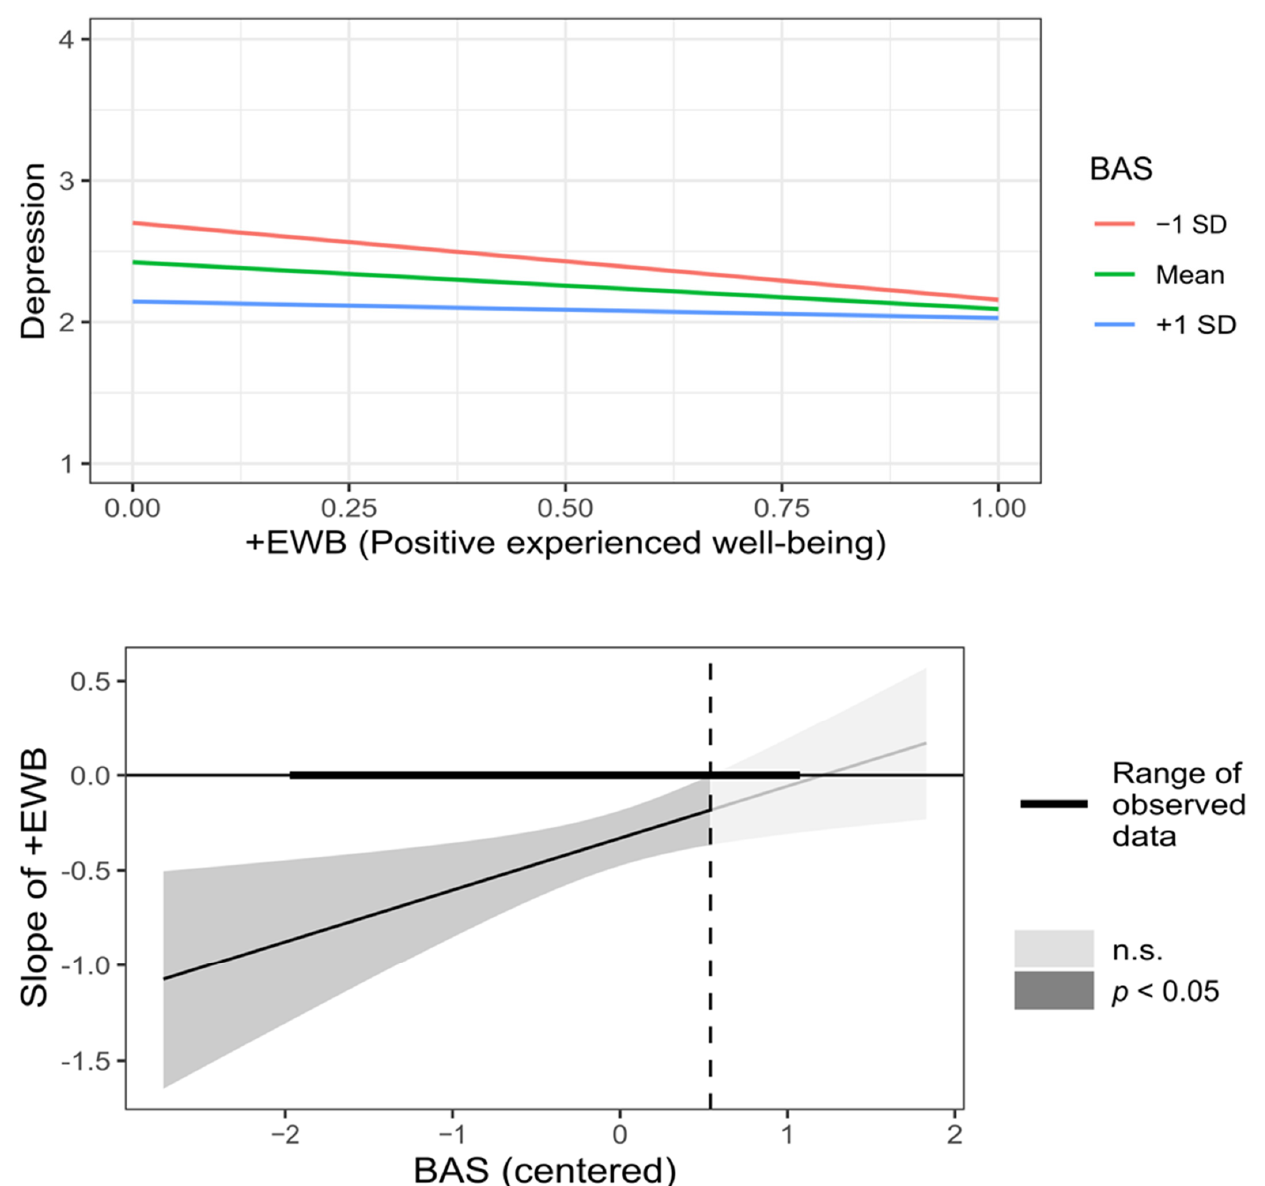
Figure 3. Graphic representation of BAS (Beliefs about stress) moderation on the relationship between +EWB (Positive experienced well-being) and depression symptoms.